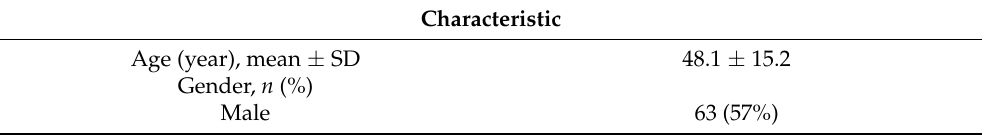
Table 1. Demographics of this study